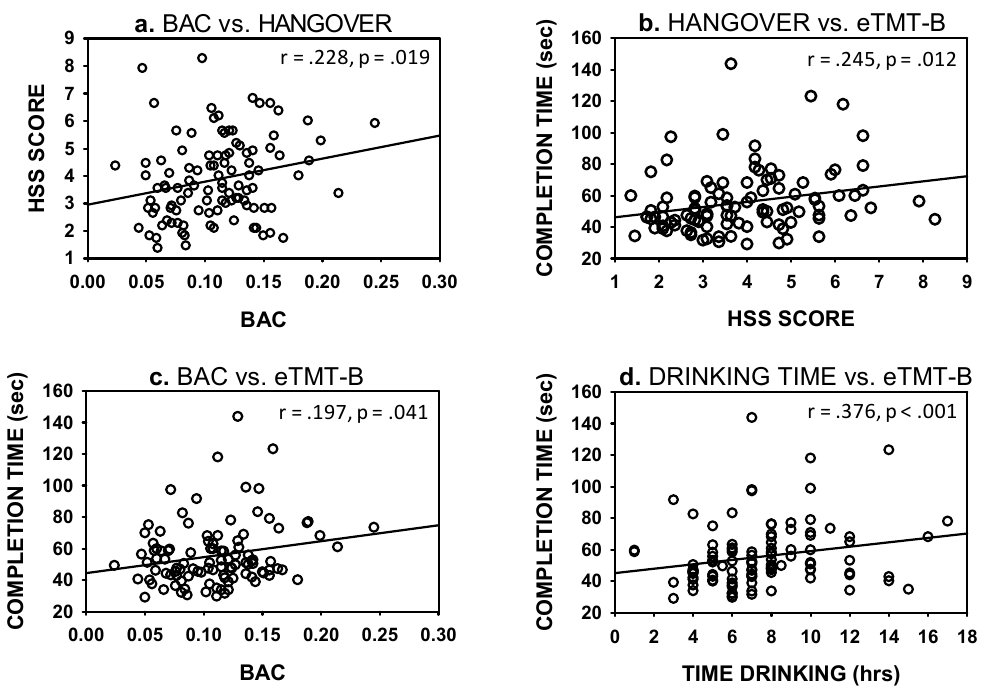
Figure 2. Graphs depicting significant associations between a. previous night’s breath alcohol content (BAC) and hangover severity (Hangover Severity Scale (HSS) score), b . hangover severity and cognitive performance (eTMT-B), c. BAC and cognitive performance d. drinking time and cognitive performance.